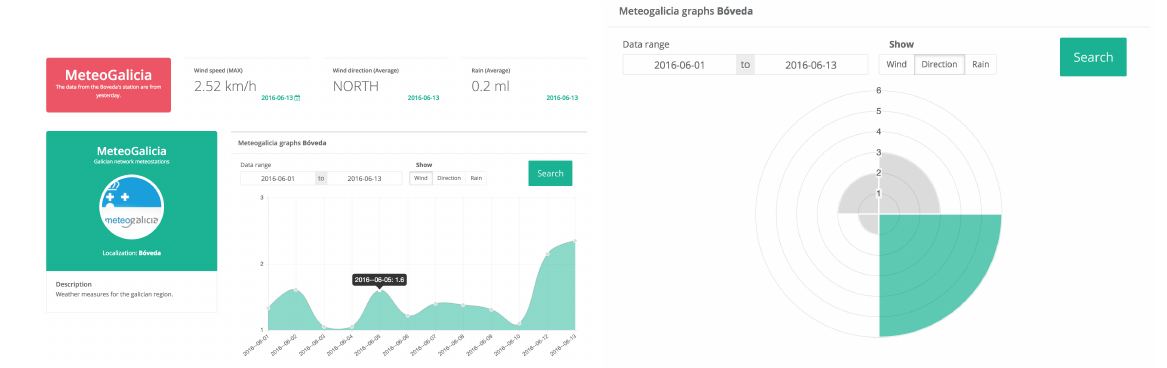
Figure 17. Wind speed ( left ) and direction ( right ) read by the weather station on 1–13 June 2016.